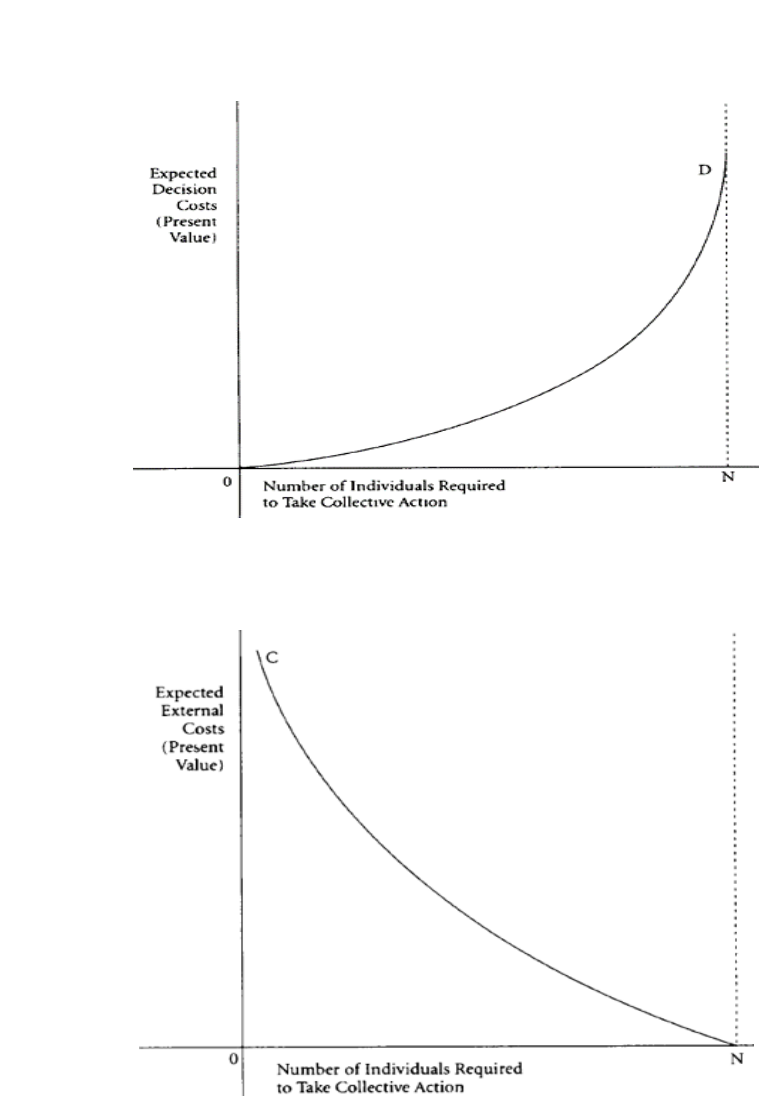
Fig. 6. The decider number’s influence on the decision cost and external cost (Buchanan & Tullock, 1999, pp.